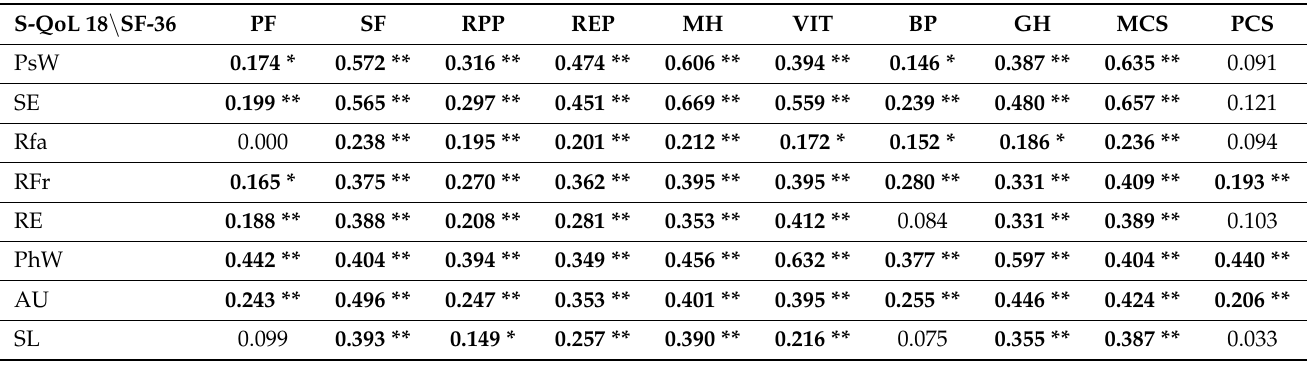
Table A2. Correlations between the S-QoL 18 Dimensions and the SF-36